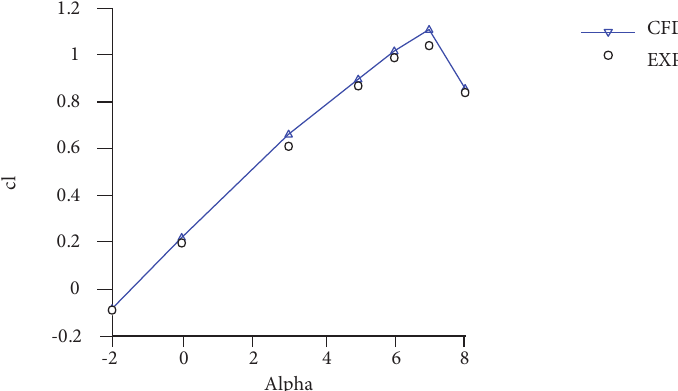
Figure 12. Lift coefficient distribution, Mach =